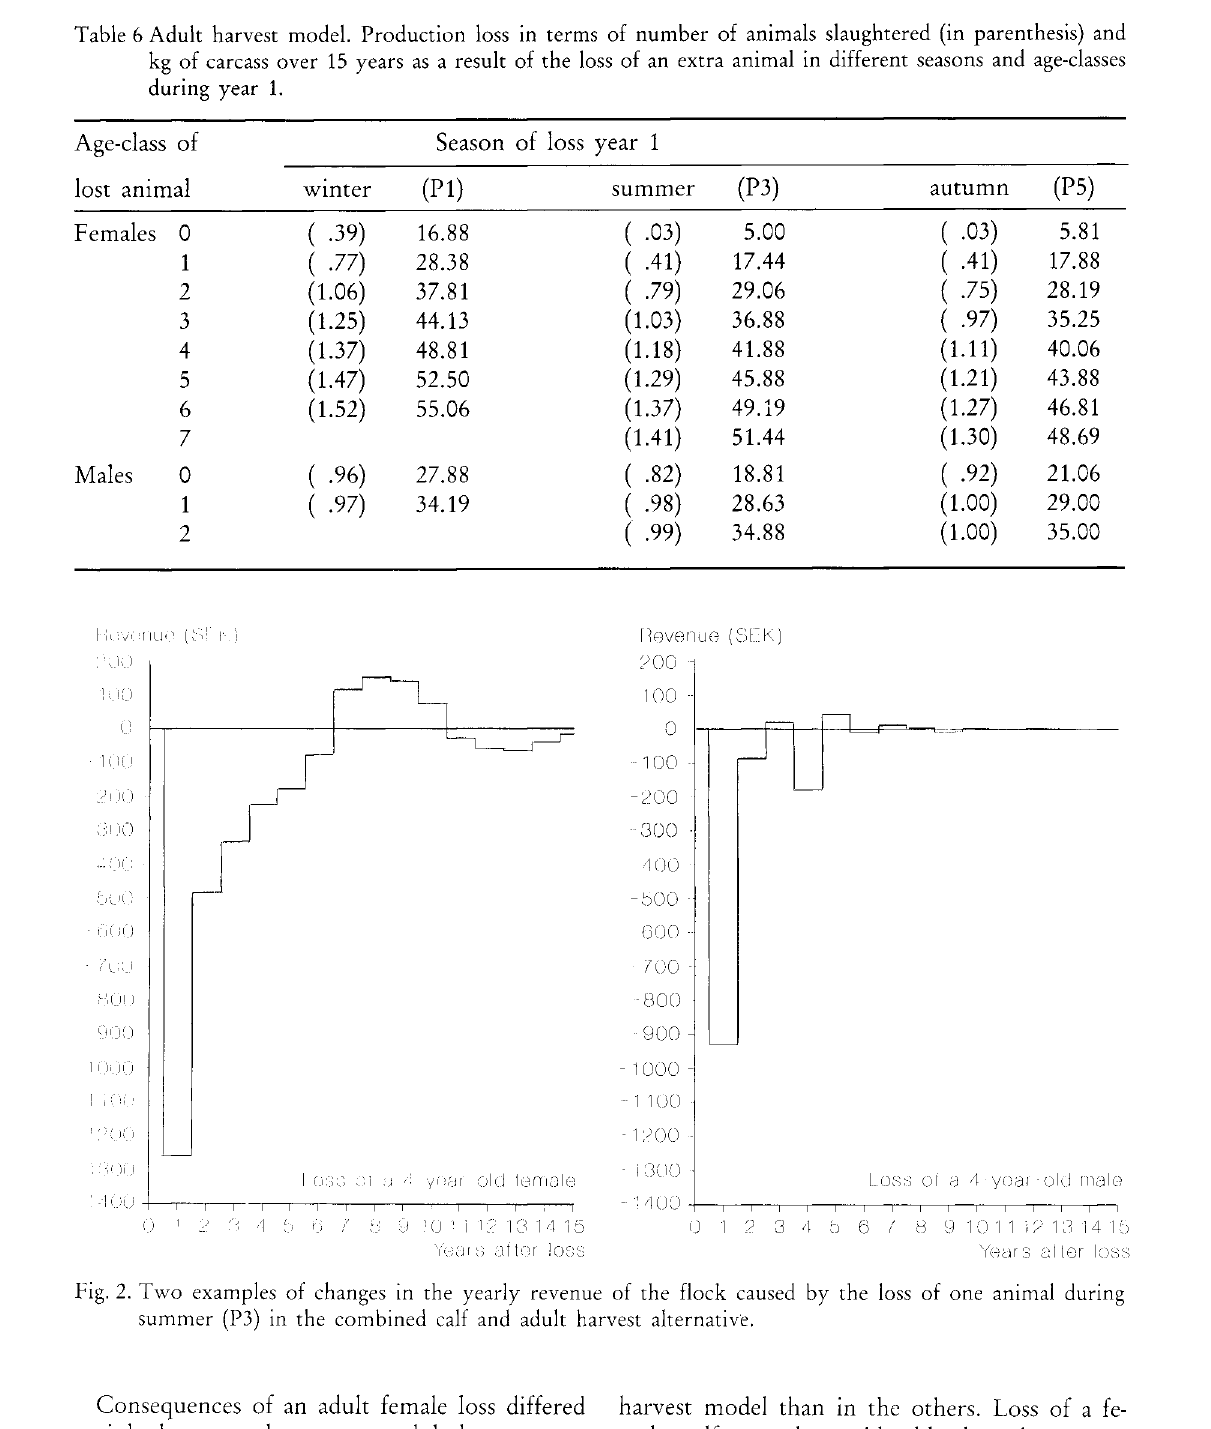
Fig. 2. T wo examples of changes in the yearly revenue of the flock caused by the loss of one animal during summer (P3) in the combined calf and adult harvest